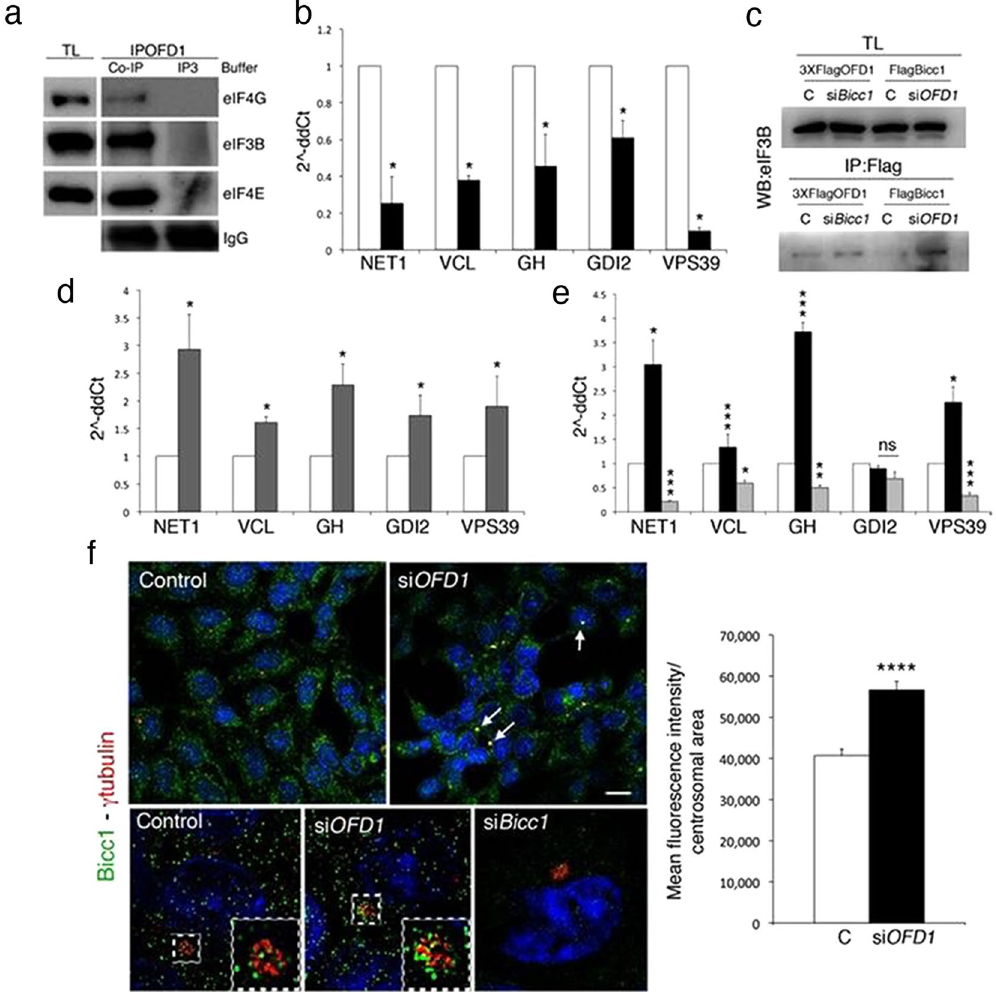
Figure 5. OFD1 cooperates with Bicc1 to control the translation of specific mRNAs. ( a ) Co-IP experiments demonstrate that the IP3 buffer destroys OFD1/eIFs interactions, which are preserved using the Co-IP buffer. ( b ) Real-Time PCR of the OFD1-bound mRNA shows that Net1, Vcl, Gh, Gdi2 and Vps39 are not enriched after OFD1 IP (black bars) compared to Control (eIF4E-IP white bars). ( c ) Silencing of Bicc1 results in stronger eIF3B/OFD1 affinity. Similar results are observed when OFD1 is silenced and eIF3B/Bicc1 interaction is analyzed. ( d ) Real-Time PCR of the Bicc1-bound mRNA shows that mRNAs target are enriched after Bicc1 IP (grey bars) compared to Control (eIF4E-IP white bars). ( e ) RNA binding experiments are performed in OFD1 - and Bicc1 -silenced cells. In the absence of OFD1 the binding of target mRNAs to eIF4E (black bars) is more efficient compared to controls (white bars); while silencing of Bicc1 results in decreased mRNA enrichment (grey bars). ( f ) IF with an antibody against Bicc1 (green) shows that Bicc1 colocalizes with γ tubulin (red) at the centrosome and that the amount of centrosomal Bicc1 increases in OFD1 -silenced cells (white arrows). Representative superresolution images are reported and a magnification of the centrosome is shown in the dotted white box. IF in Bicc1 -silenced cells is reported as control for antibody specificity. Bicc1 localization at the centrosome was quantified by ImageJ and reported in a graph on the right. Main fluorescence intensity was calculated in the centrosomal area and reported in white for controls (C) and in black for OFD1 -silenced cells (si OFD1 ). Data are presented as the mean + SEM. ns p-value > 0.05; * p-value < 0.05; *** p-value < 0.01 **** p-value < 0.005. Representative images were taken at the same contrast and reported. Bar = 5 μ